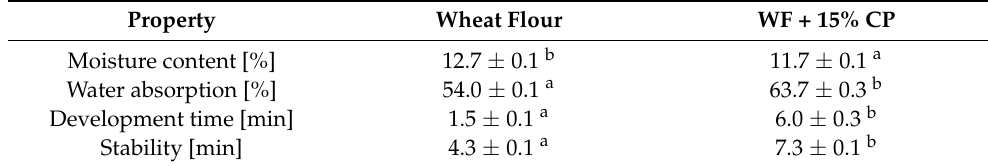
Different letters in the row mean statistically different average values ( α =